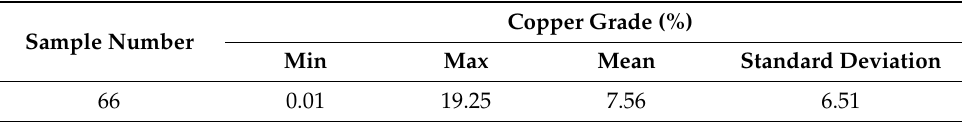
Table 1. Descriptive statistics of